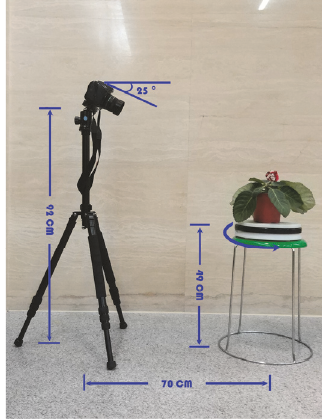
Figure 2: Image acquisition and equipment setup